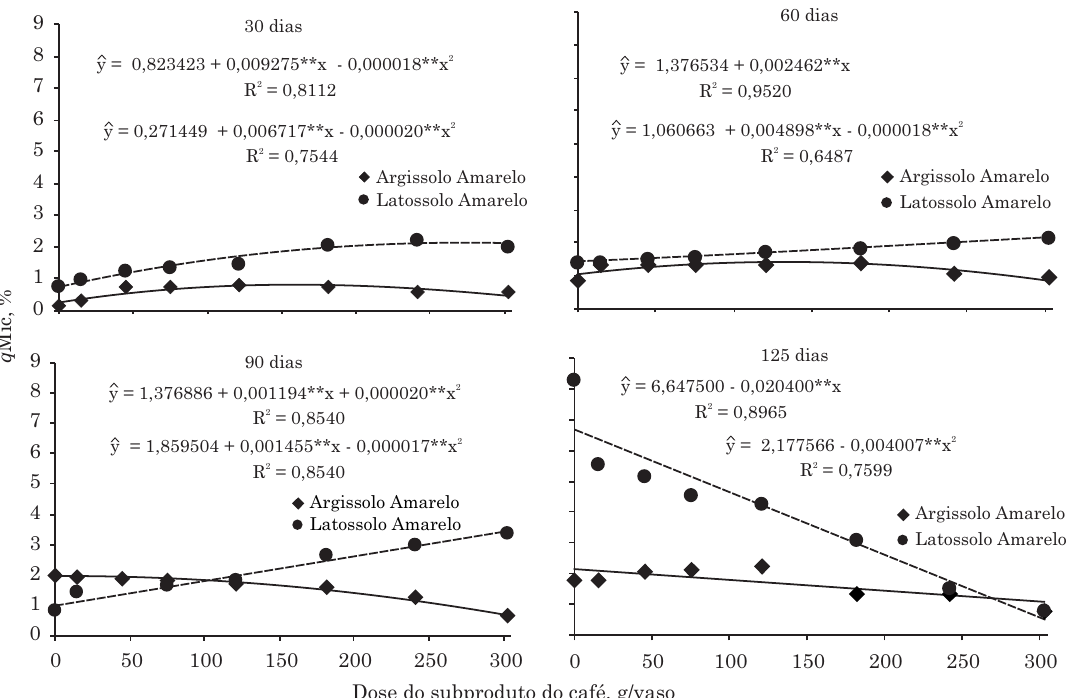
Figura 5. Quociente microbiano ( q Mic) aos 30, 60, 90 e 125 dias de incubação nas amostras do Argissolo Amarelo e Latossolo Amarelo, em função da aplicação de doses de subproduto de café e sob o cultivo de